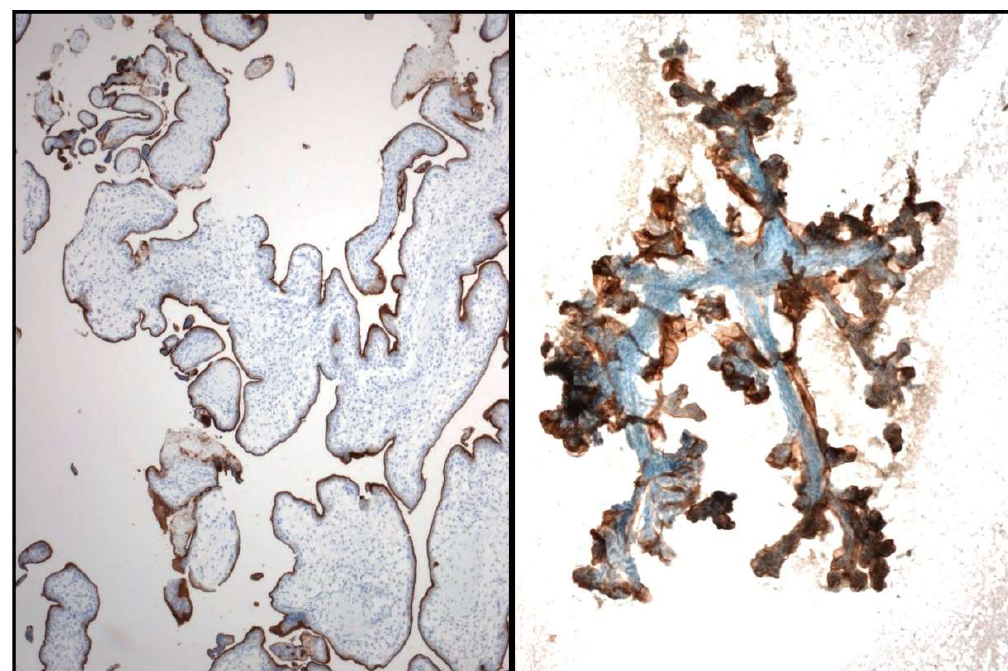
Figure 5. Some examples of PD-L1 immunostaining. Cell-block ( Left ) and smear ( Right ).